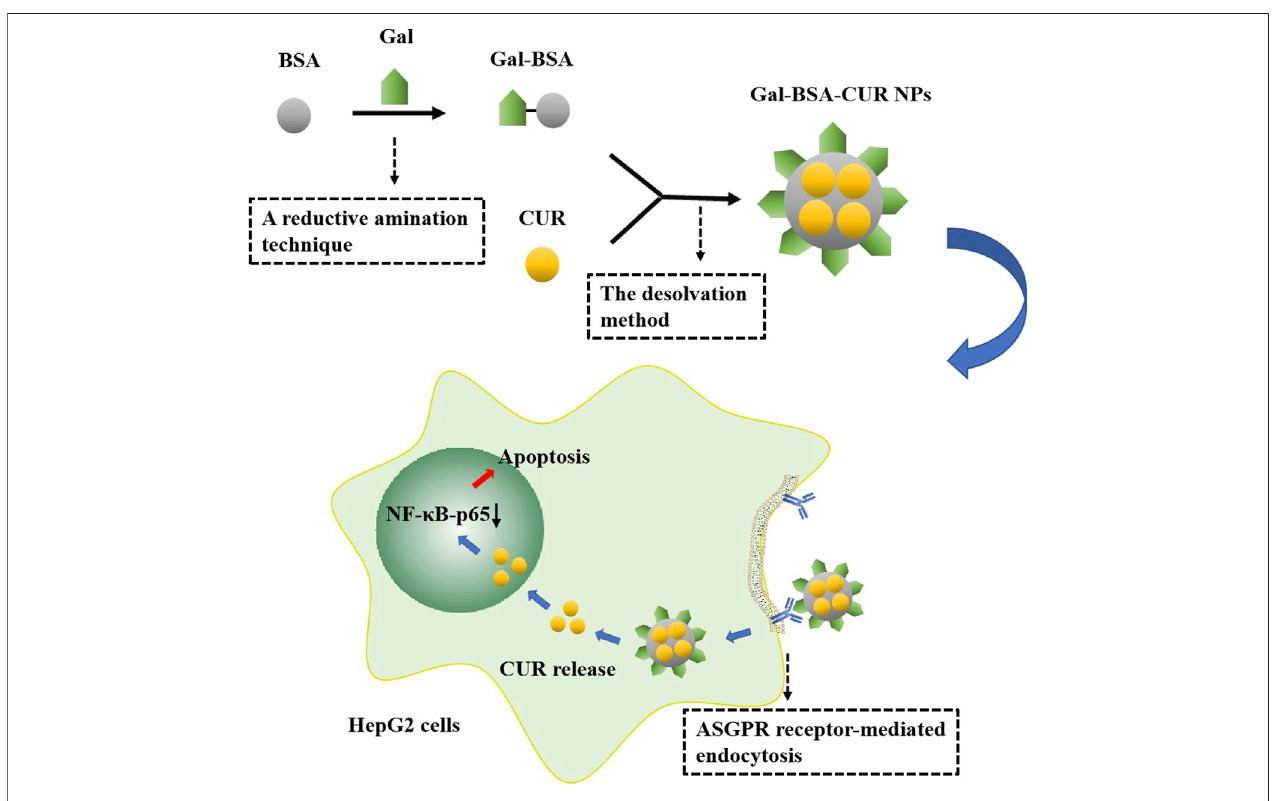
FIGURE 6 | Synthesis of Gal-BSA-CUR NPs and antitumor effect. Gal-BSA was prepared by a reductive animation technique. Then, Gal-BSA-CUR NPs were synthesized by the desolvation method. The NPs taken up into cells through ASGPR receptor – mediated endocytosis releases CUR, which can inhibit the expression of NF- κ B-p65 in the nucleus and induce cell